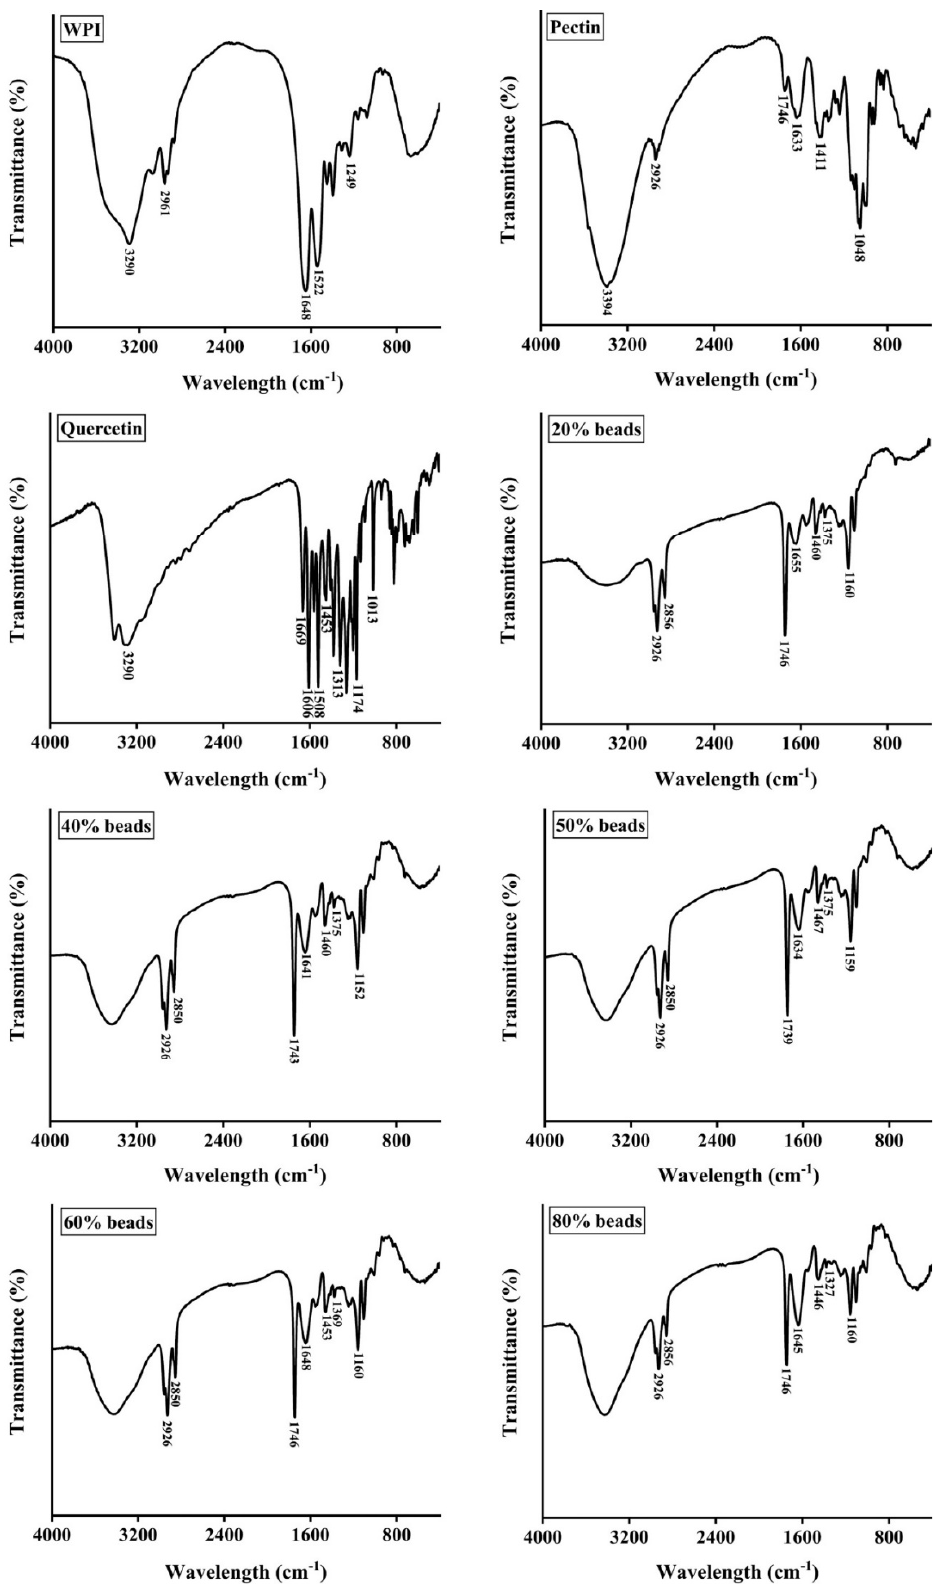
Figure 3. FTIR spectra of whey protein isolate (WPI), pectin, quercetin, and hydrogel beads. 20% beads, 40% beads, 50% beads, 60% beads and 80% beads represent hydrogel beads produced by WPI emulsion and different content of pectin (20%, 40%, 50%, 60% and 80%, respectively).